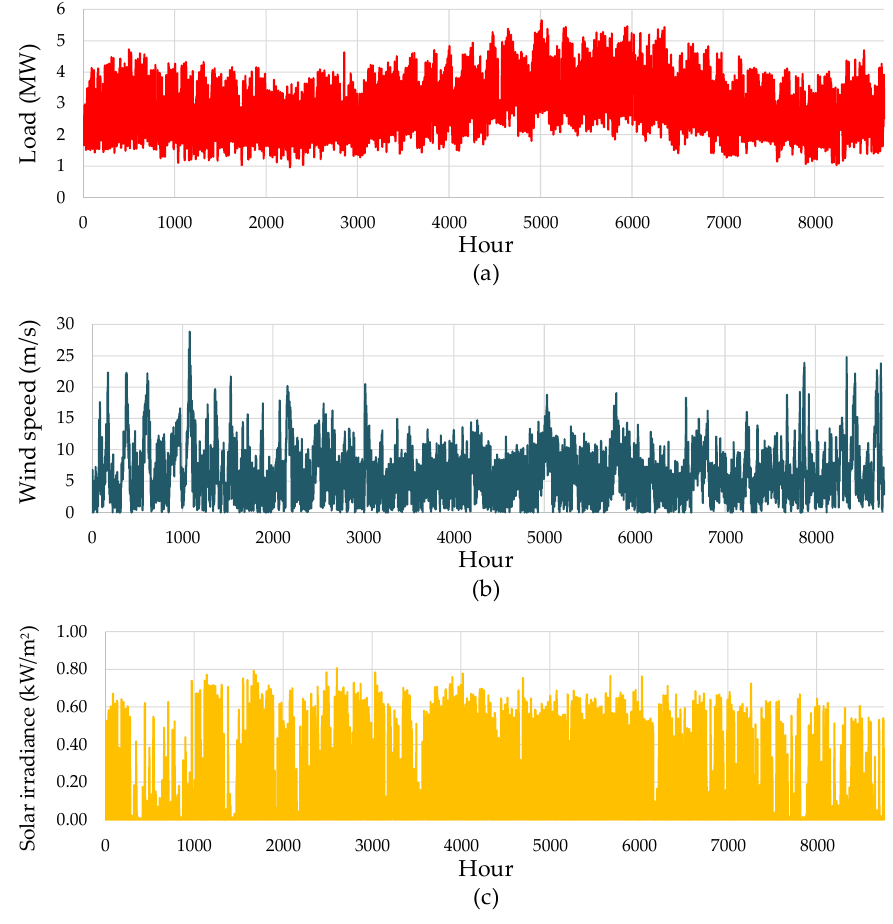
Figure 1. Hourly data of: ( a ) load demand, ( b ) wind speed, and ( c ) solar irradiance of a year. Similarly, based on the hourly solar irradiance data, the generation profile of a solar DG unit